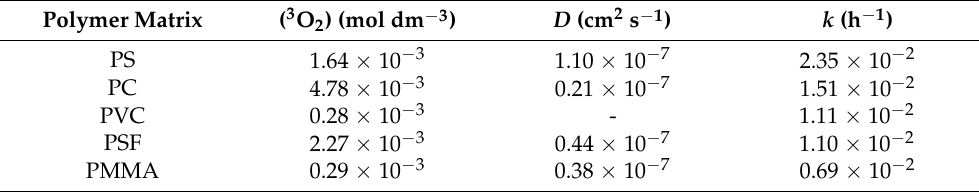
Table 1. Equilibrium molecular oxygen concentrations ( 3 O 2 ), corresponding coefficients of diffusion (D) and pseudo-first-order rate constants for BZ consumption (k) for irradiation of BZ in various polymer matrices at ambient temperature in